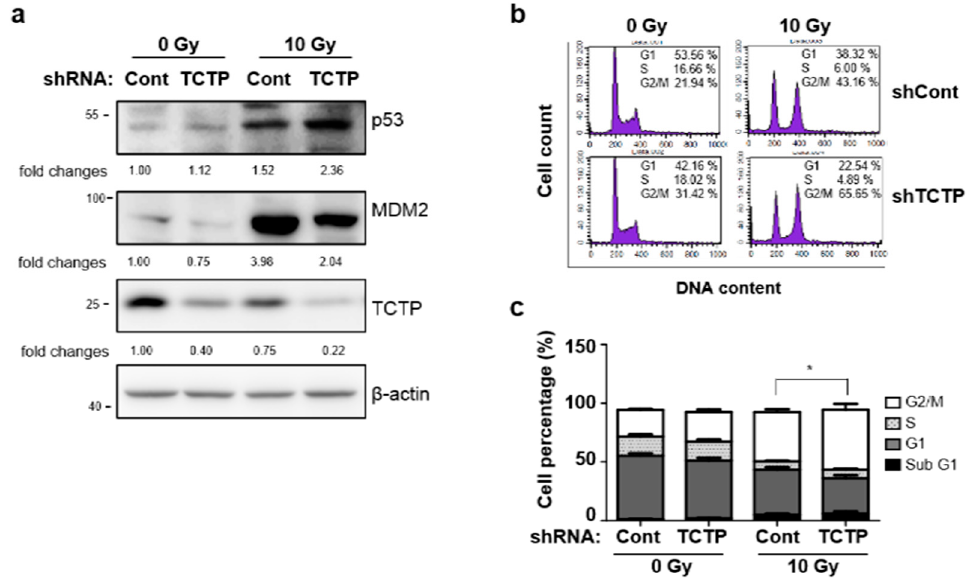
Figure 5. Cont. Figure 5.